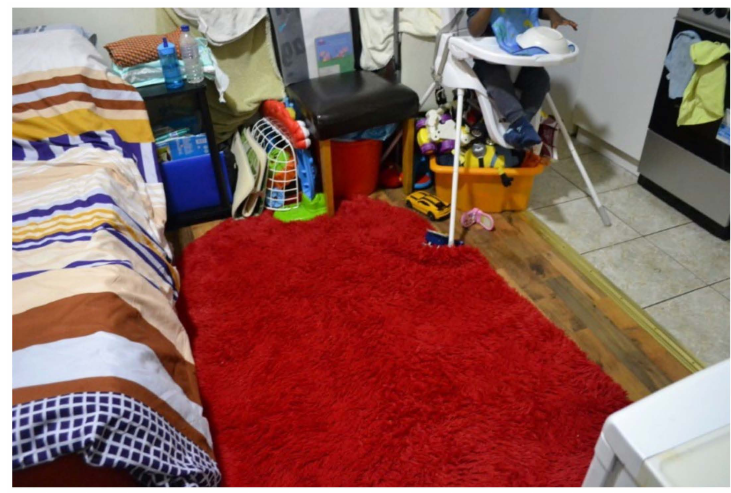
Figure 18. House visit.